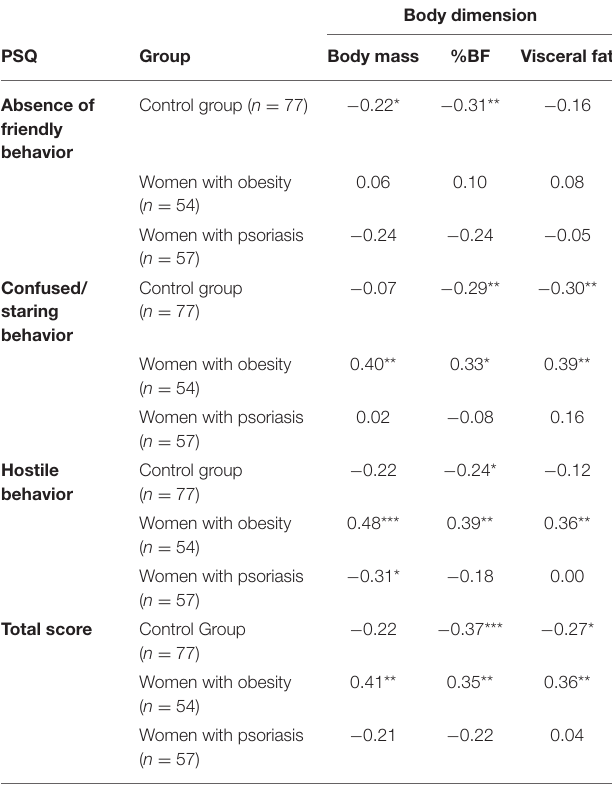
Frontiers in Psychiatry |